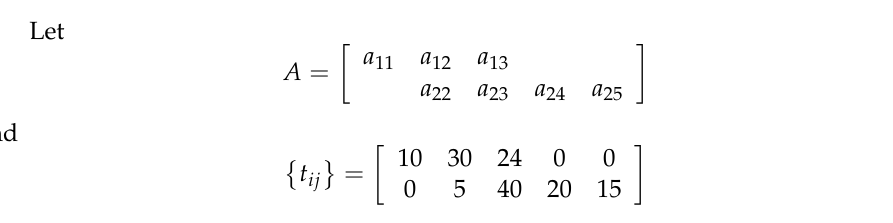
Figure 6. Assembly line with seven workstations.